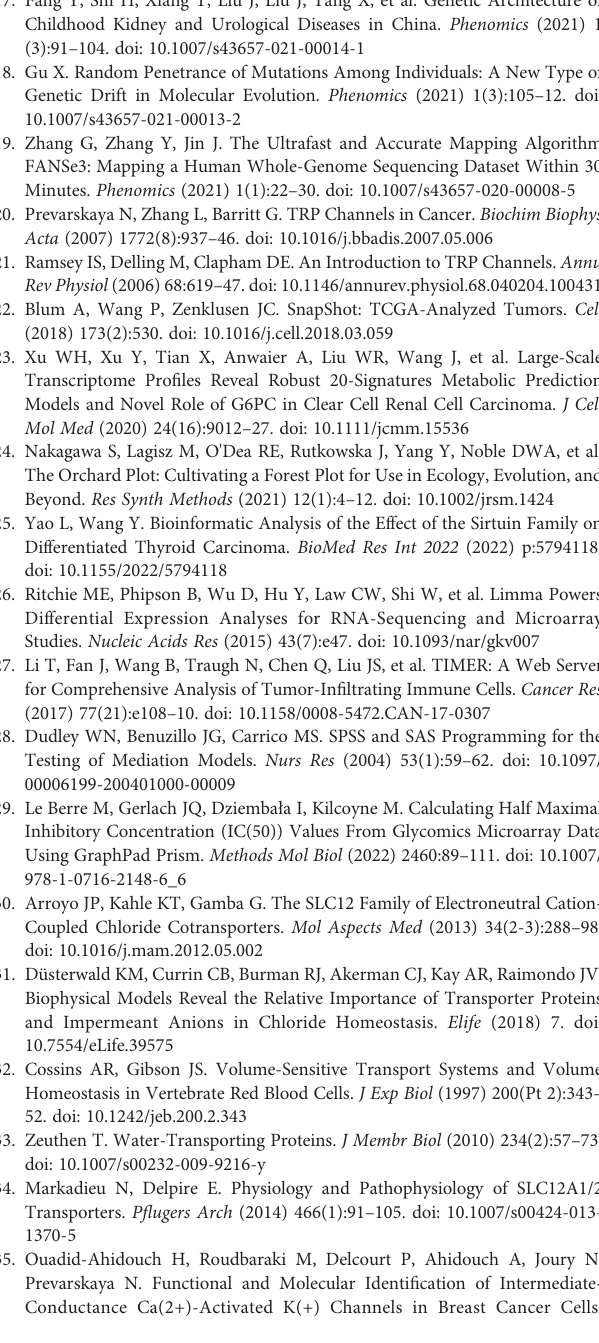
Supplementary Figure 1 | The correlation between copy number variation and expression of KCC2 and NKCC1 in cancers. (A) Correlation between CNV